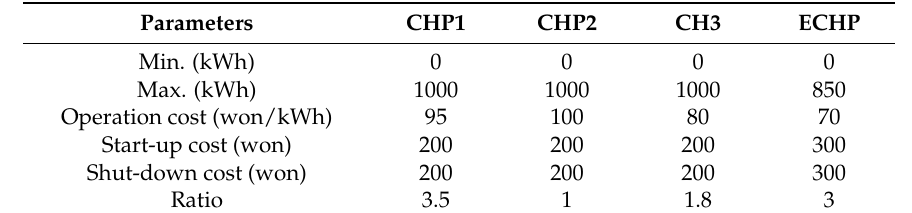
Table 1. Parameter of CHPs and ECHP.